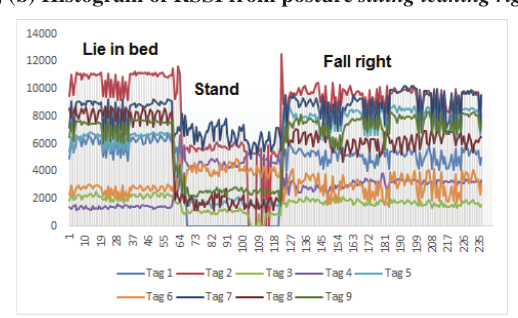
Figure 3: (a) Histogram of RSSI from posture sitting leaning left ; (b) Histogram of RSSI from posture sitting leaning right